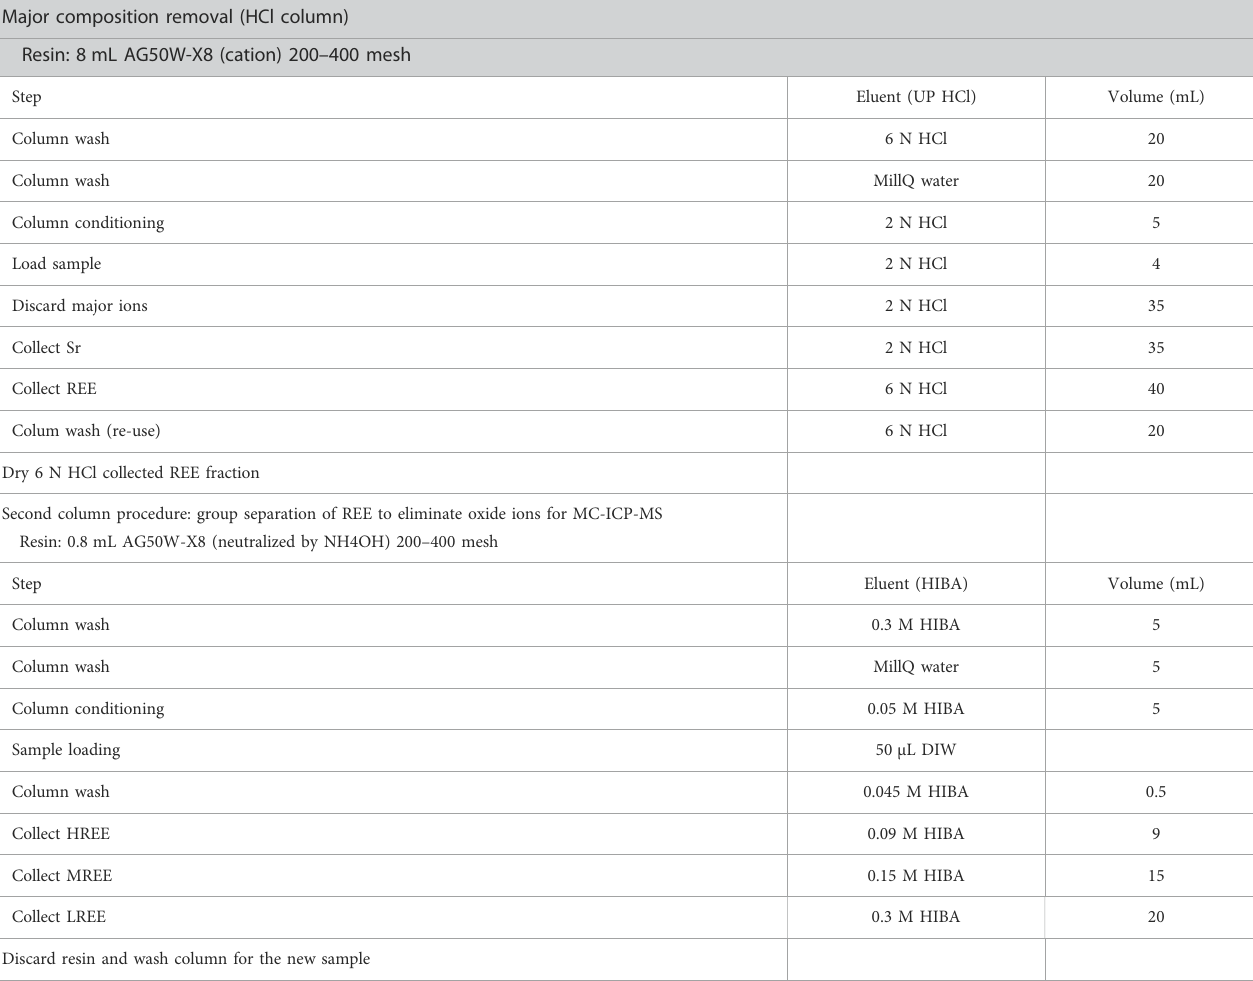
TABLE 2 Ion chromatography procedure for group separation of REE in this study, modi fi ed from Tanaka et al. (2018). Major composition removal (HCl column)